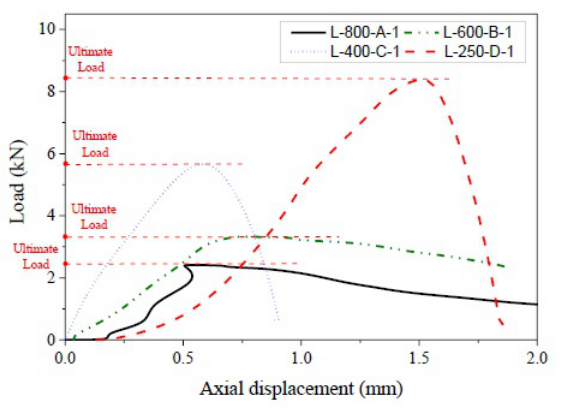
Figure 6: Load-axial displacement curves for tubes with different